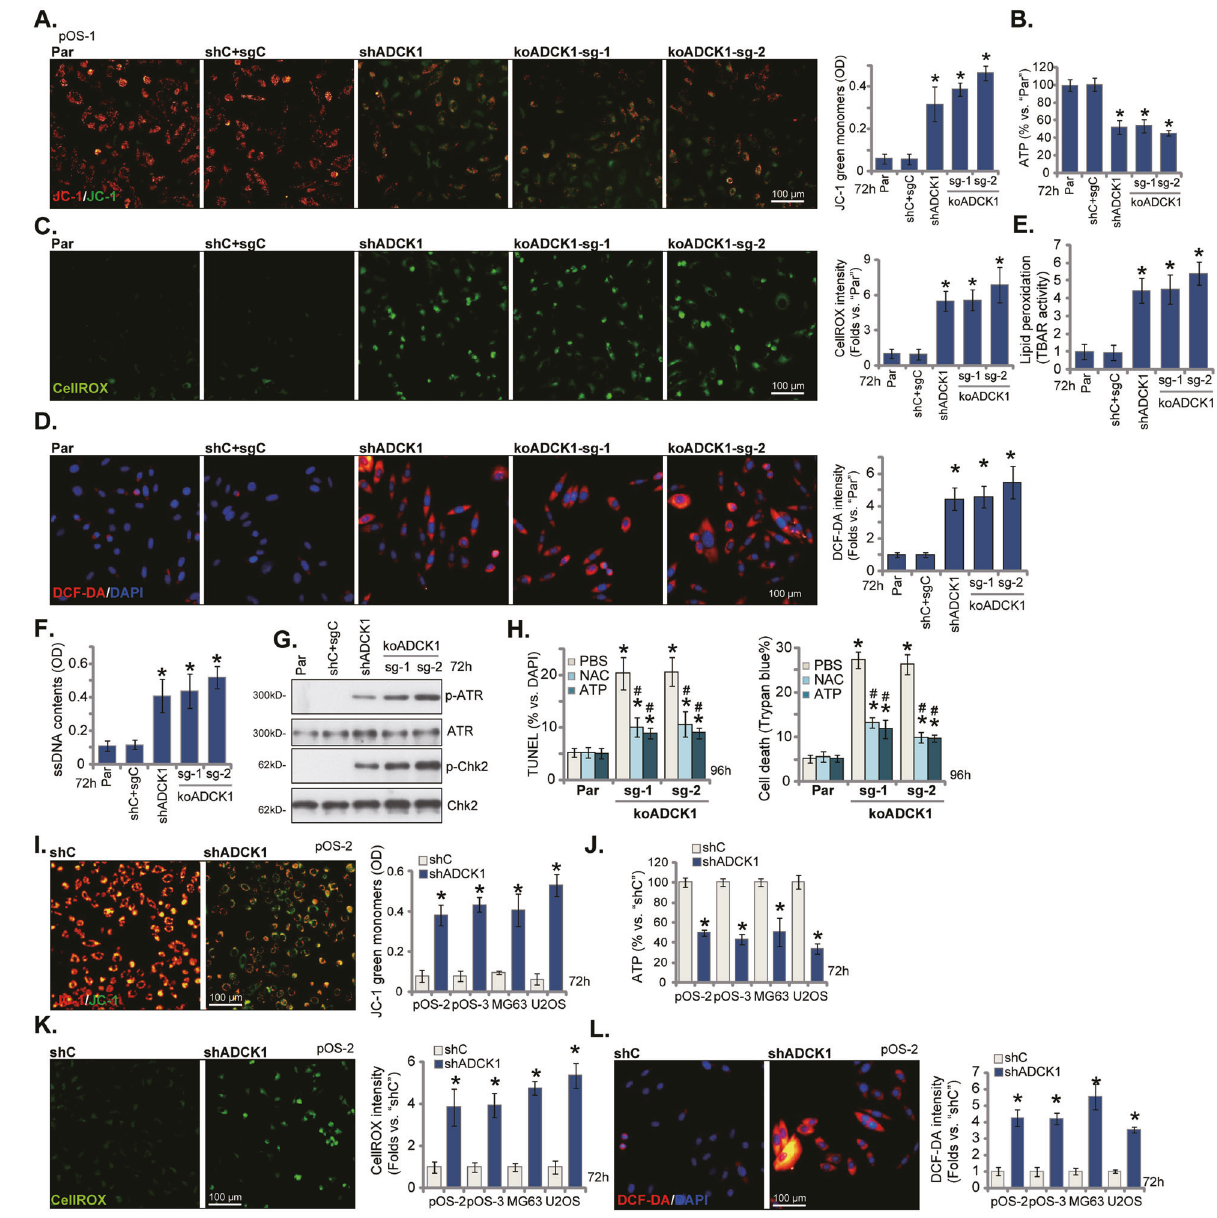
Fig. 4 ADCK1 silencing or KO disrupts mitochondrial functions in OS cells. Stable pOS-1 primary cells, bearing the lentiviral ADCK1 shRNA ( “ shADCK1 ” ), the lentiviral CRISPR/Cas9 construct with sgRNA targeting ADCK1 , “ koADCK1-sg-1 ” and “ koADCK1-sg-2 ” , or the lentiviral scramble control shRNA plus the CRISPR/Cas9 empty vector ( “ shC + sgC ” ), were established and cultured for applied time periods; Mitochondrial depolarization (by measuring JC-1 green monomers intensity, A ) and ATP contents ( B ) were tested; Oxidative injury was measured by CellROX staining ( C ) and DCF-DA staining ( D ) assays, with lipid peroxidation (TBAR activity assays, E ) and single strand DNA (ssDNA) contents (ELISA assays, F ) examined as well. Expression of the listed DNA damage proteins was shown ( G ). Stable pOS-1 primary cells, bearing the lentiviral CRISPR/Cas9 construct with sgRNA targeting ADCK1 , “ koADCK1-sg-1 ” and “ koADCK1-sg-2 ” , were treated with the antioxidant N-Acetyl-L- cysteine ( “ NAC ” , 500 μ M), ATP (2 mM) or the vehicle control ( “ PBS ” ) and cultured for 96 h, cell death and apoptosis were tested by Trypan blue staining and TUNEL staining assays, respectively ( H ). The primary human OS cells (pOS-2 and pOS-3) as well as the established lines (MG63 and U2OS), stably expressing the lentiviral ADCK1 shRNA ( “ shADCK1 ” ) or the lentiviral scramble control shRNA ( “ shC ” ), were established and cultured for applied time periods, mitochondrial depolarization ( I ), ATP contents ( J ) and ROS (CellROX intensity and DCF-DA intensity, K and L ) were tested similarly. “ Par ” stands for the parental control cells. Data were presented as mean ± standard deviation (SD, n = 5). * P < 0.05 vs. “ Par ” / “ shC ” cells. # P < 0.05 vs. “ PBS ” treatment ( H ). The experiments were repeated fi ve times with similar results obtained. Scale bar = 100 μ m ( A , C , D , J – L ). In the shADCK1 pOS-1 cells, re-expression of a shRNA-resistant (by recording Trypan blue-positive cells, Fig. 3G) in pOS-1 cells. ADCK1 construct ( “ shR-ADCK1 ” ) restored ADCK1 protein expres- These results implied that apoptosis activation should be the main sion (Fig. S1D). Importantly, shADCK1-induced proliferation mechanism responsible for ADCK1 depletion-induced cytotoxicity (nuclear EdU ratio) inhibition (Fig. S1E), migration reduction (Fig. in OS cells.